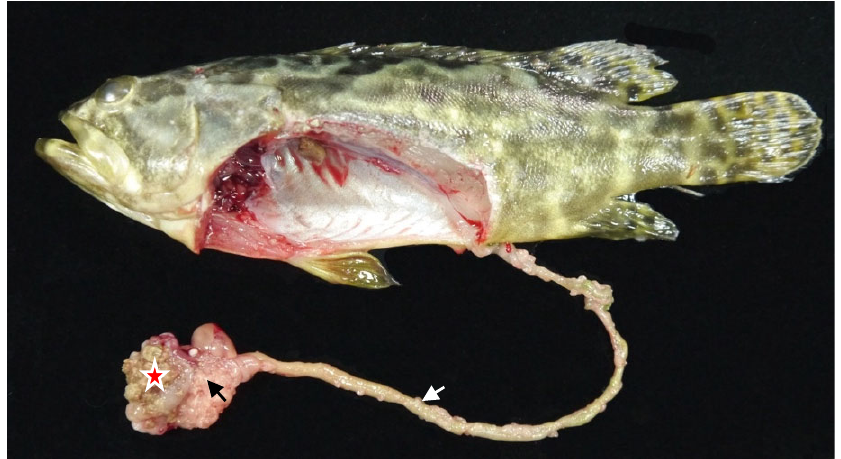
Figure 2. Elementary tract of hybrid Sabah grouper. Star denotes a stomach filled with feed, black arrow indicates pyloric caeca, and white arrow indicate intestine.